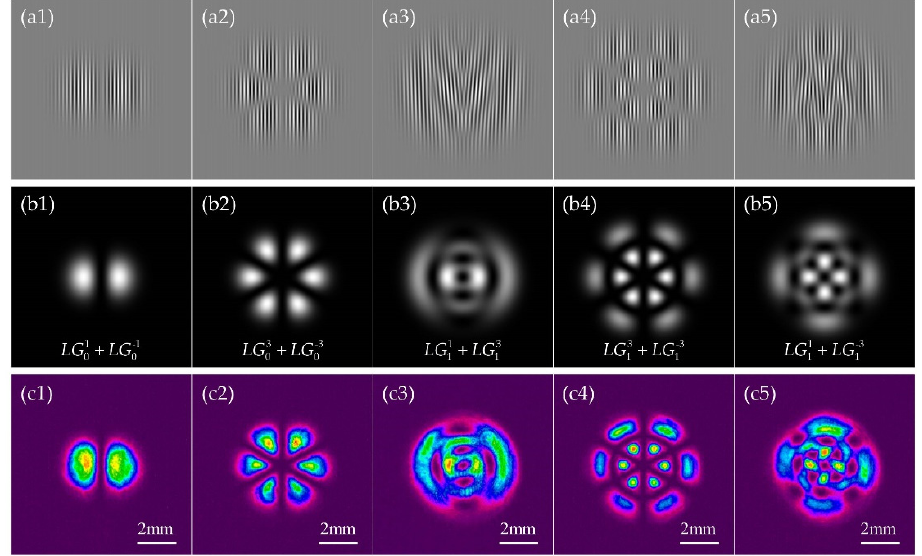
Figure 2. ( a1 – a5 ) The corresponding CGH phase patterns of composite OAM beams. ( b1 – b5 ) Sim- ulated and ( c1 – c5 ) experimental intensity distributions of composite OAM beams. Simulated and ( c1 – c5 ) experimental intensity distributions of composite OAM